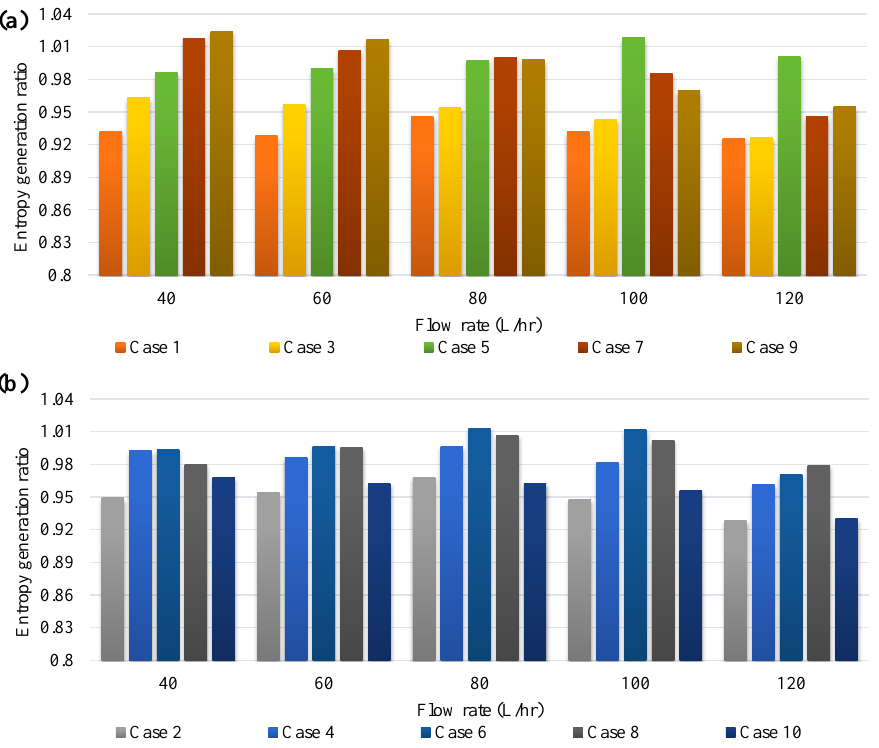
Figure 4. Entropy generation ratio of ( a ) fully porous and ( b ) semi-porous cases at different flow rates for the inlet temperature of 20 °C.